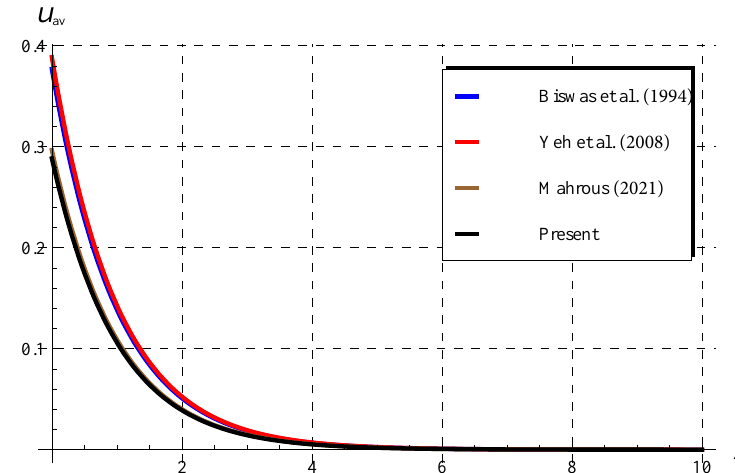
Figure 9. Comparisons between the present cup-mixing average concentration u av and the corre- sponding ones in literature as α → 1 when A 0 = 1.4 and A 2 = 0.5